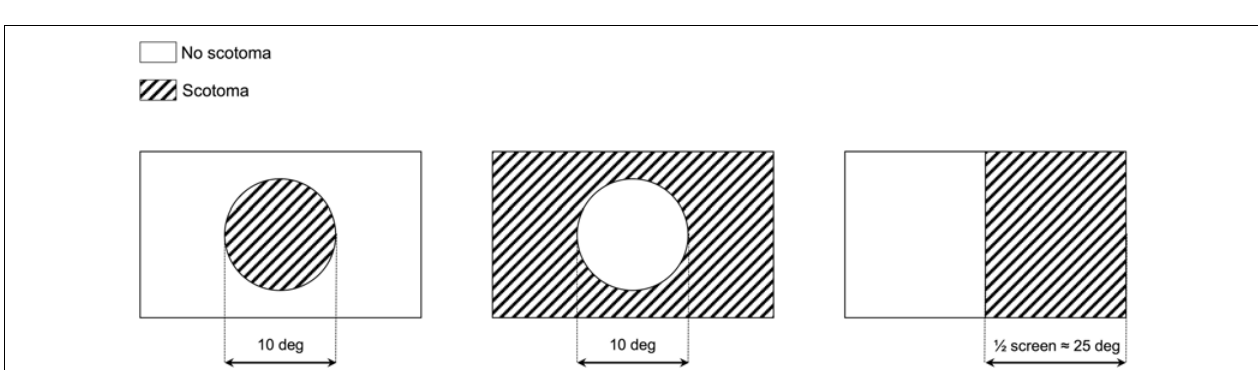
FIGURE 2 | Schematic representation of the simulated visual field defects (VFD) used in this study. From left to right: central loss (scotoma size: 10 ◦ ), peripheral loss (scotoma size: whole screen except for a 10 ◦ hole), hemifield loss (right half of the screen). During the experiment, the VFD was applied in a gaze-contingent manner: the center of the VFD is matched in real-time with the point of gaze of the participant, with a latency below 4 ms. This latency roughly corresponds to the inter-frame interval and ensures proper gaze-contingency.